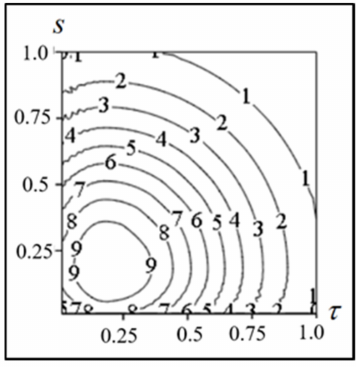
Figure 5. Estimation of the kernel ˆ K 2 ( τ , s ) , built on exact data.